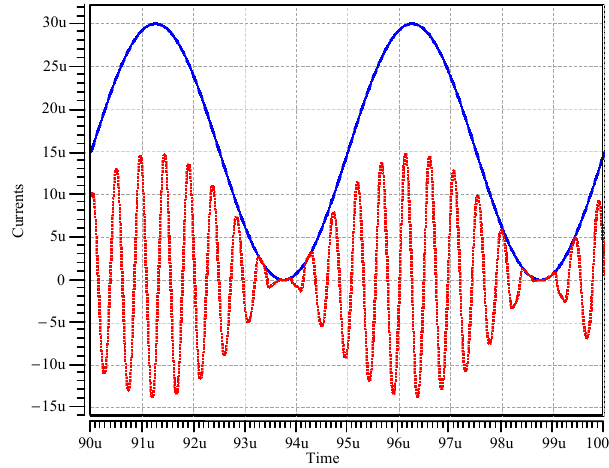
Figure 9. Simulated result of operation as an AM signal generator when I B 2 is the applied sinusoidal signal.